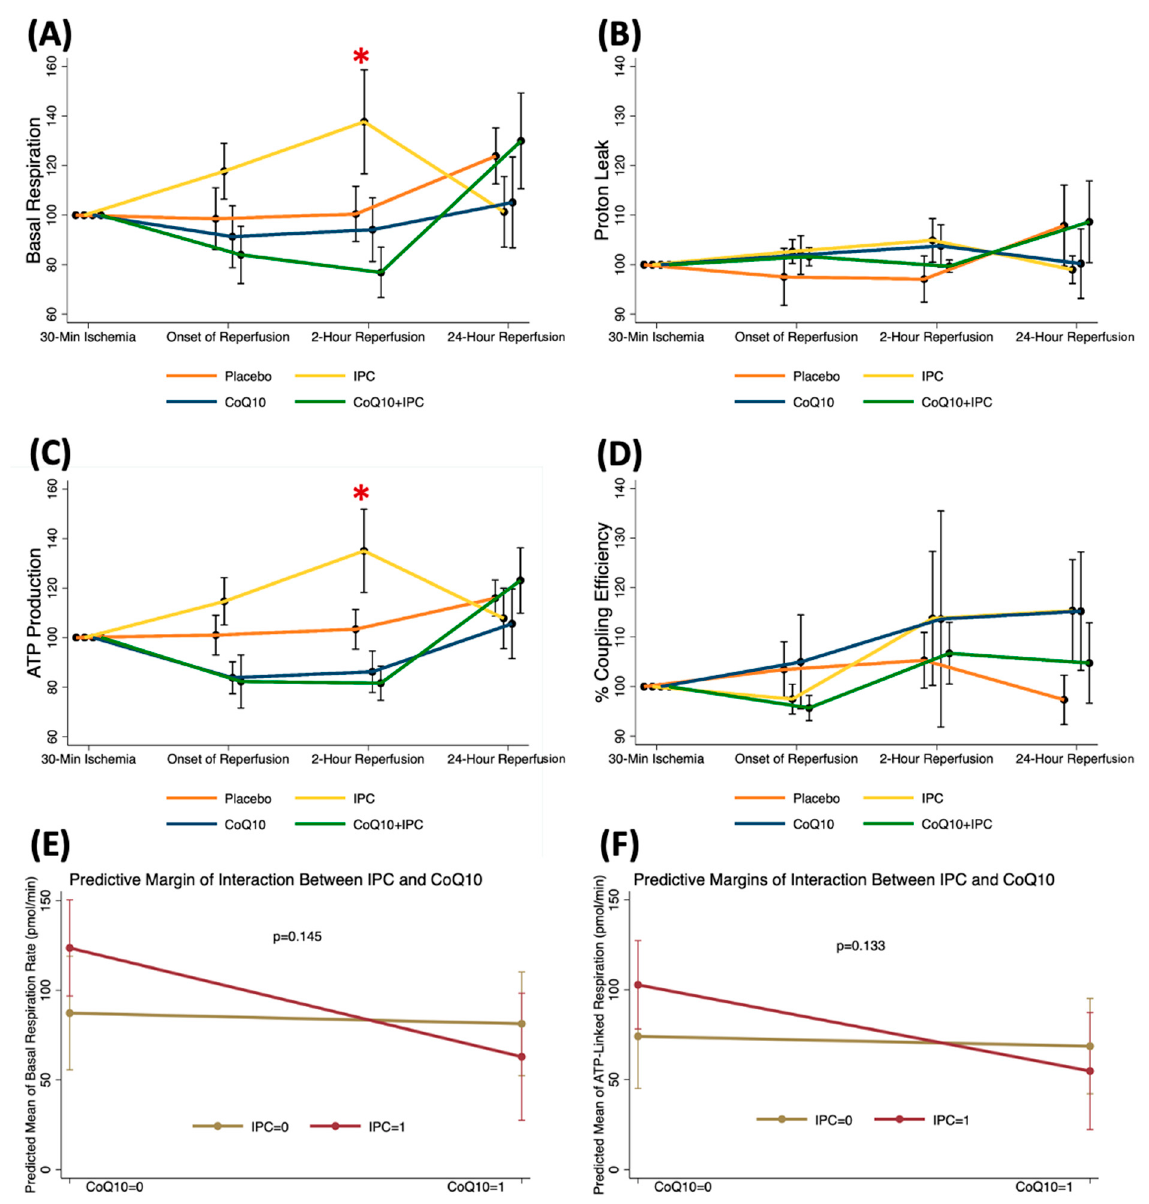
Figure 4. Mitochondrial respiration alteration following early phase of tourniquet-induced ischemia and reperfusion in TKA patients receiving placebo vs. IPC vs. CoQ10 vs. CoQ10 + IPC. ( A ) basal respiration, ( B ) proton leak, ( C ) ATP production, ( D ) % coupling efficiency, ( E ) predicted mean of basal respiration, ( F ) predicted mean of ATP production. Results are presented as differences from ischemic data. * p < 0.05 between 2-h reperfusion and 30-min ischemic data in the IPC group.